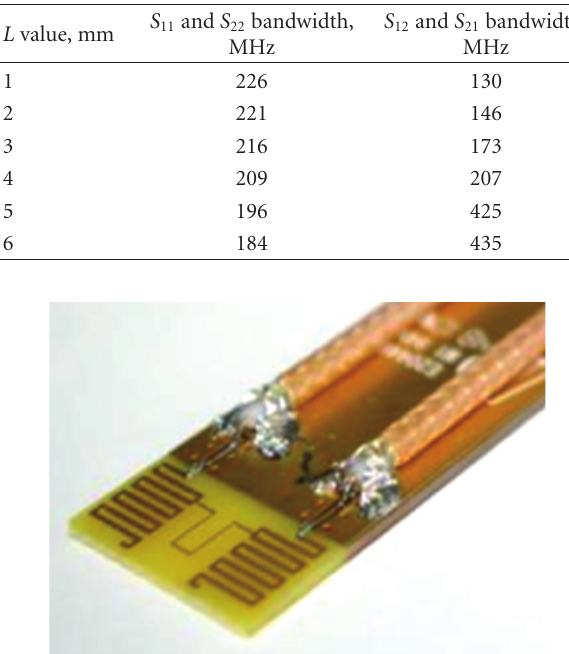
Figure 5: Photo of the fabricated MIMO antenna system #1 with assembled cables.